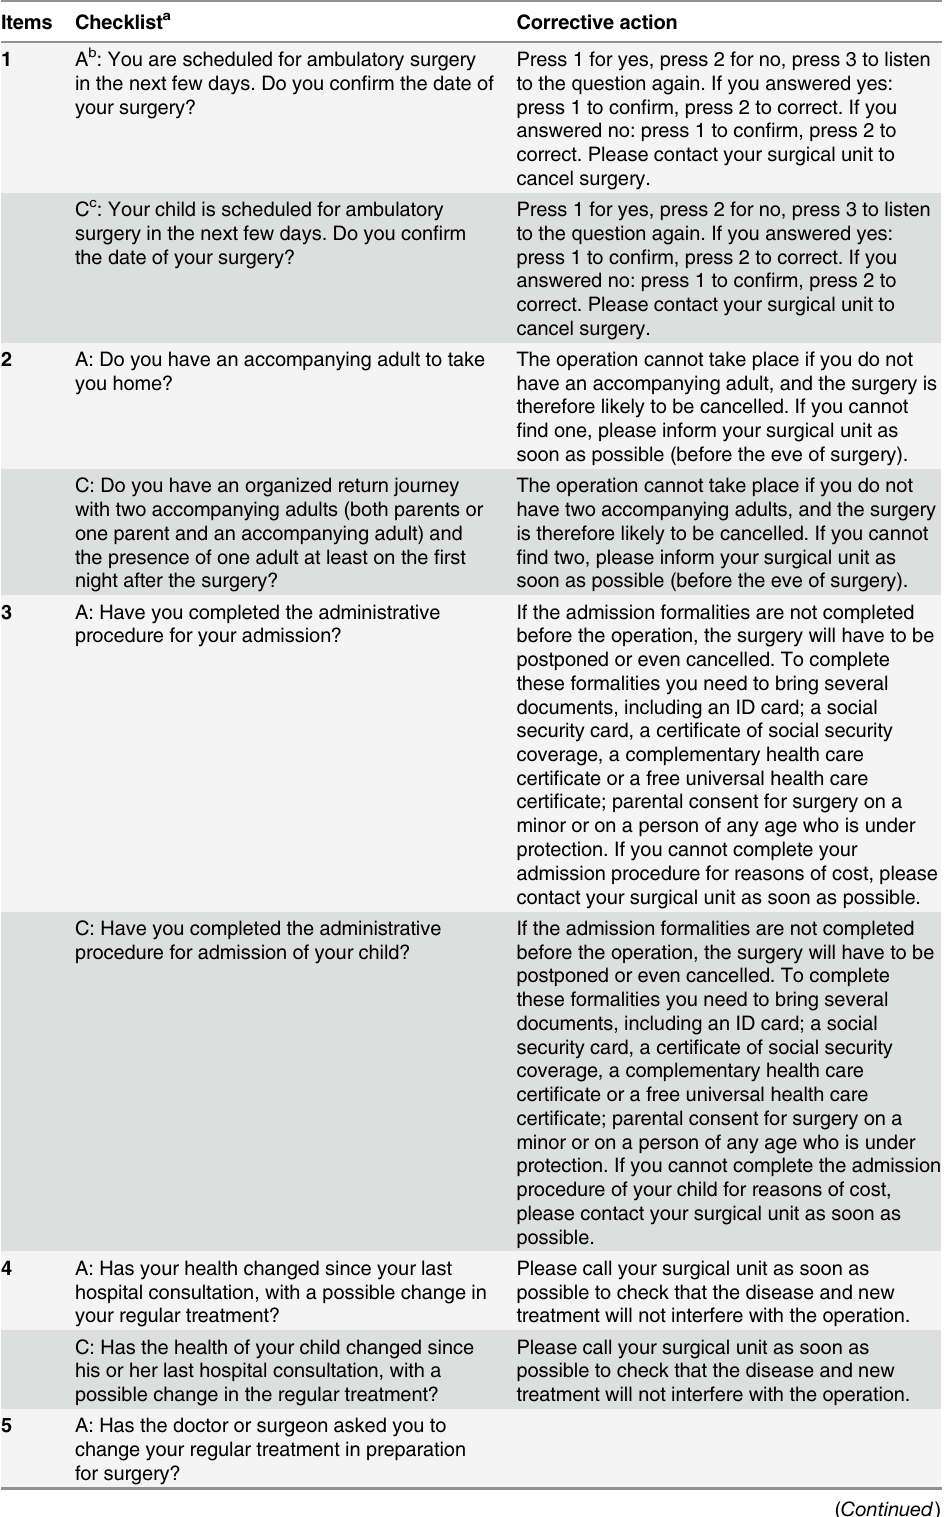
Table 1. The AMBUPROG